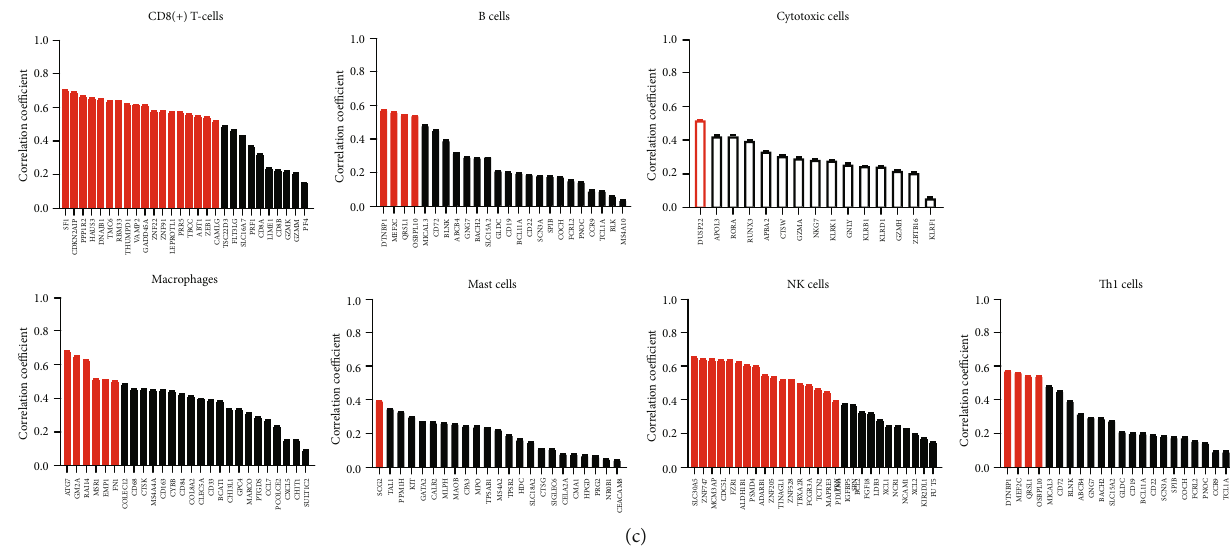
Figure 4: STK3 is correlated with CD8+ T cell in fi ltration and the NF- κ B signaling pathway in ovarian cancer. (a) Representative GO and KEGG categories a ff ected by the STK3 expression in OVCAR8 cells. (b) Gene set enrichment analysis (GSEA) using reactome gene sets compared the TCGA ovarian database. NES: normalized enrichment score. (c) The correlation between STK3 and speci fi c gene signatures of di ff erent immune